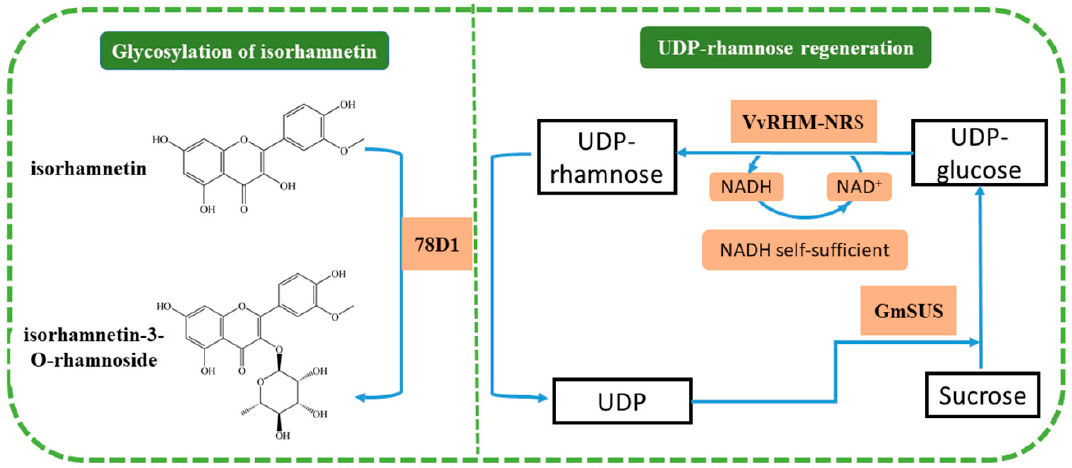
Figure 1. Schematic diagram of synergistic catalysis for isorhamnetin-3- O -rhamnoside by the combination of uridine diphosphate (UDP)-rhamnose regeneration and glycosylation of isorhamnetin.